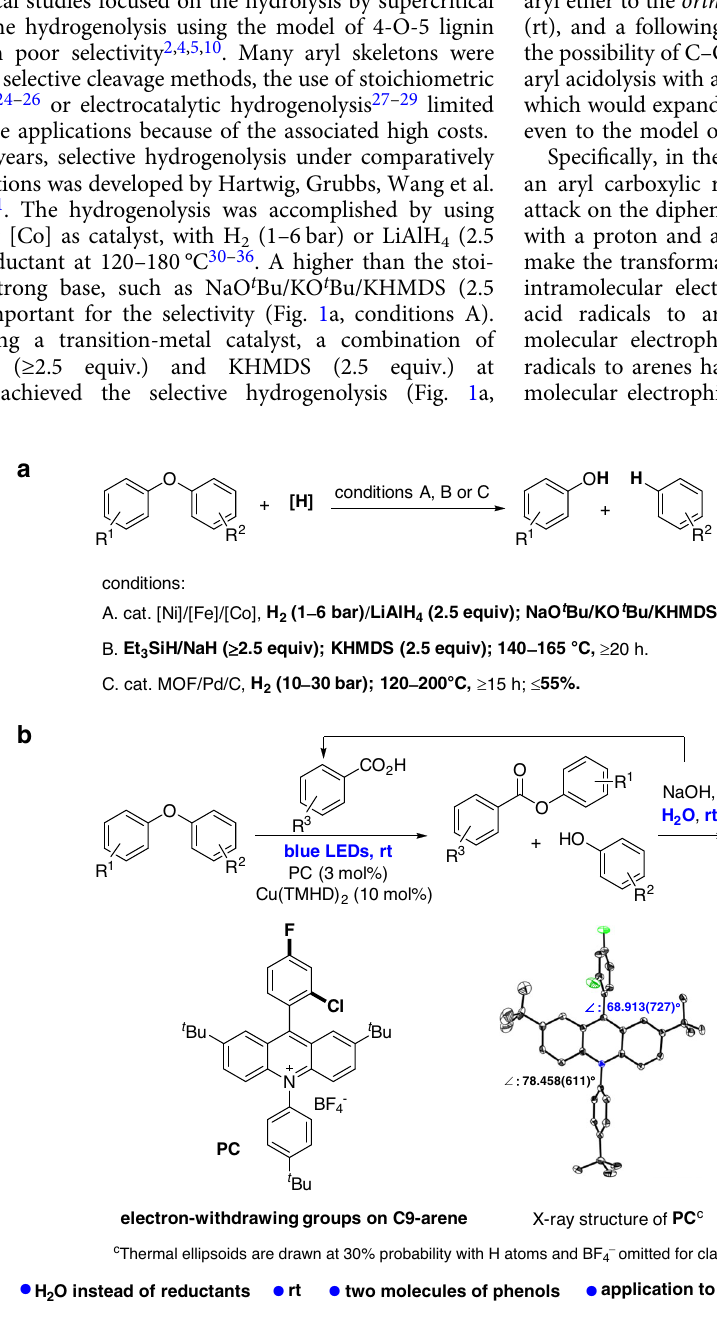
Fig. 1 Selective C – O bond cleavage of diaryl ethers. a Typically selective hydrogenolysis of diaryl ethers 30 – 41 . b This work: visible-light photoredox- catalyzed acidolysis of diaryl ethers and the following